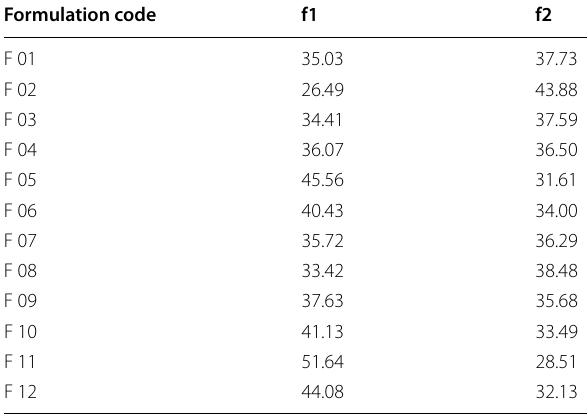
Table 11 Difference factor (f1) and similarity factor (f2) values